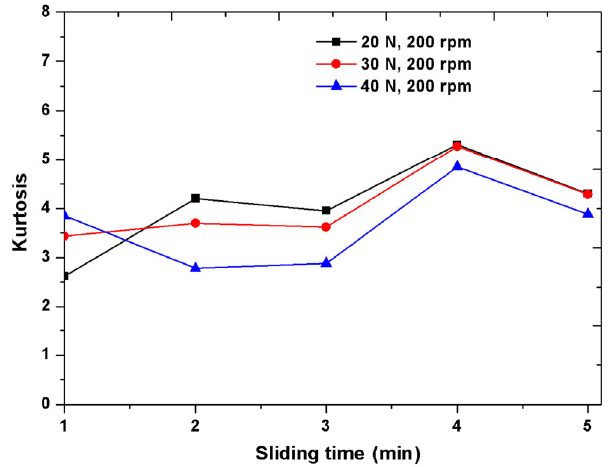
Fig. 18 Variation of S ku with sliding time for the same speed and different